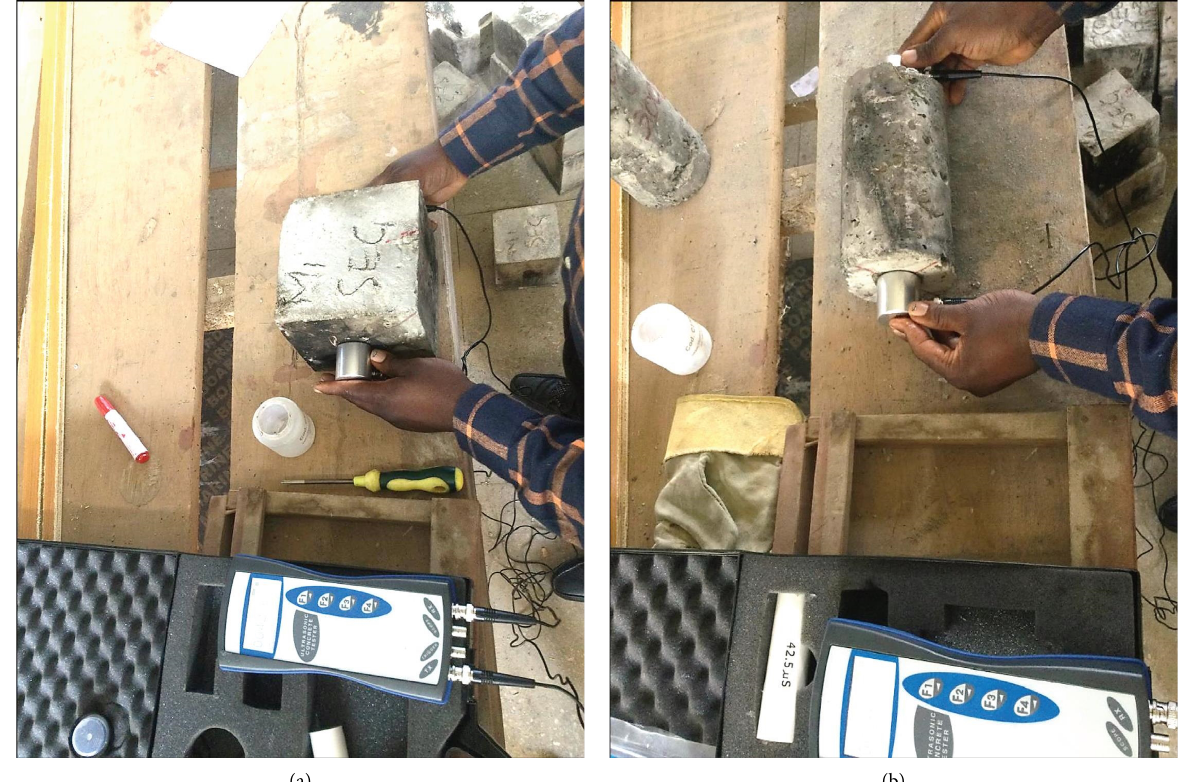
Figure 7: Ultrasonic pulse velocity test on hardened concrete cube and cylinder.